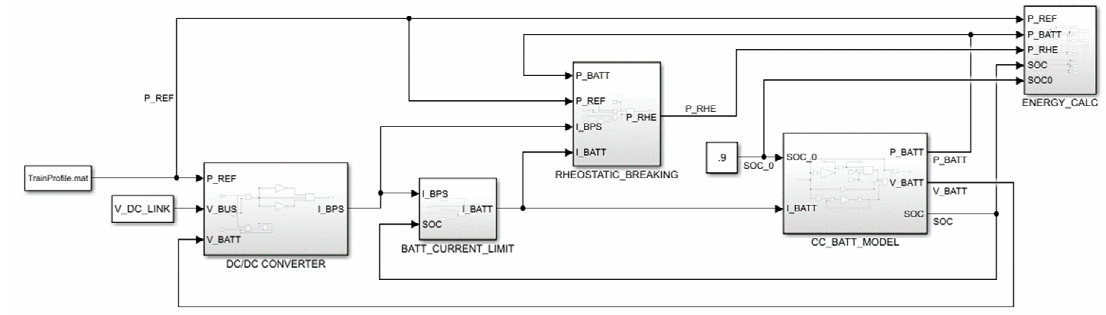
Figure 6. Battery based ESS Simulink model.